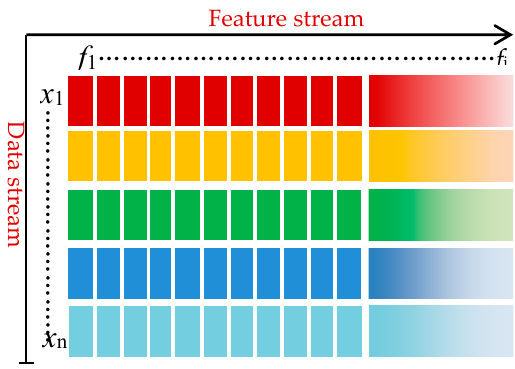
Figure 1. A feature stream with a fixed data stream.